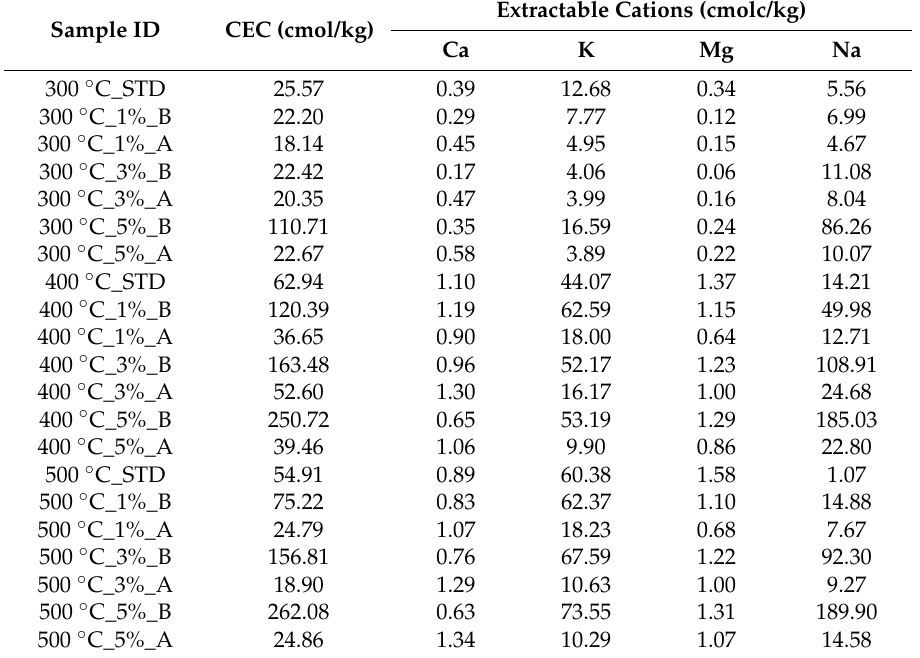
Table 3. CEC of salty food waste derived-biochar before and after